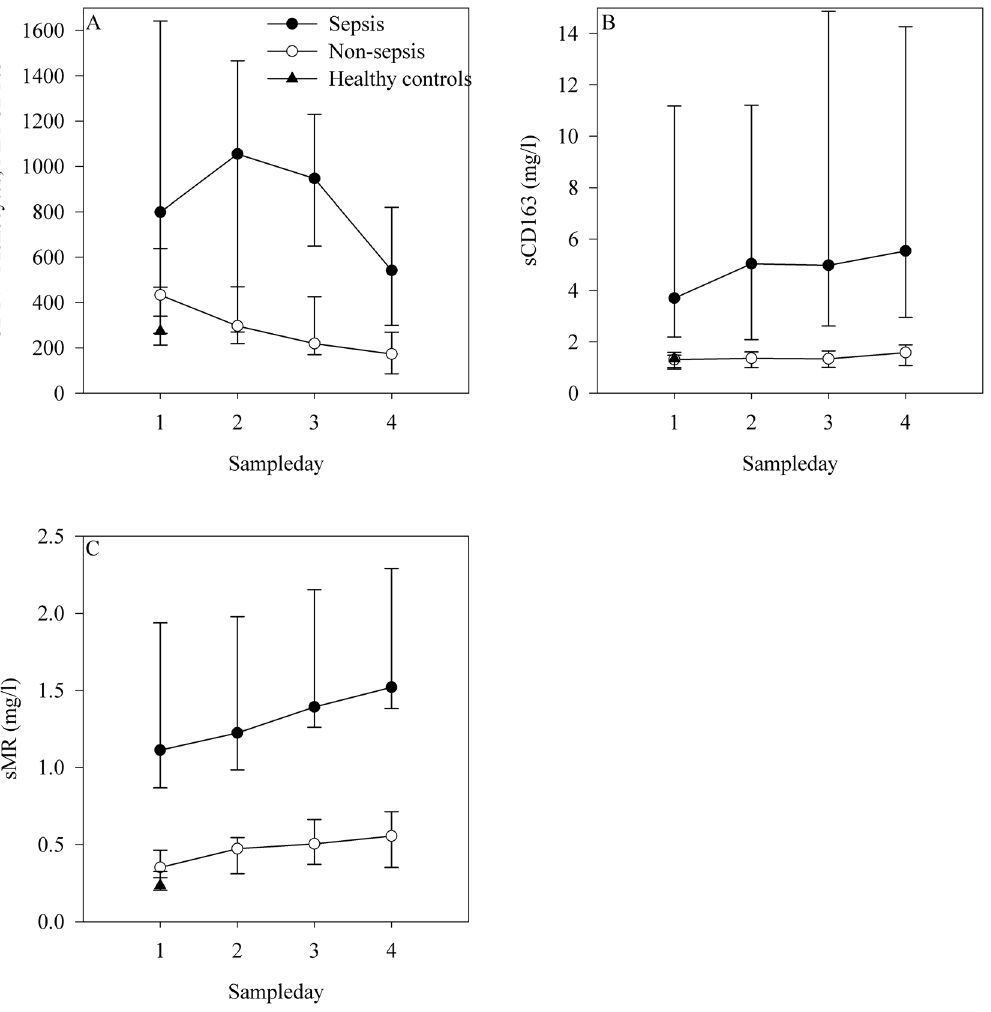
Figure 1. Levels of sCD163, sMR and the expression of monocyte-bound CD163 during the four-day observation period. A-C: At ICU admission and during the four-day observation period, expression of monocyte-bound CD163 (Panel A), sCD163 (Panel B), and sMR (Panel C) was significantly higher in septic patients compared with non-septic patients and healthy controls. The x-axis represents time and the y-axis represents the expression or level of each potential biomarker. Dots represent the median, bars represent the interquartile range.